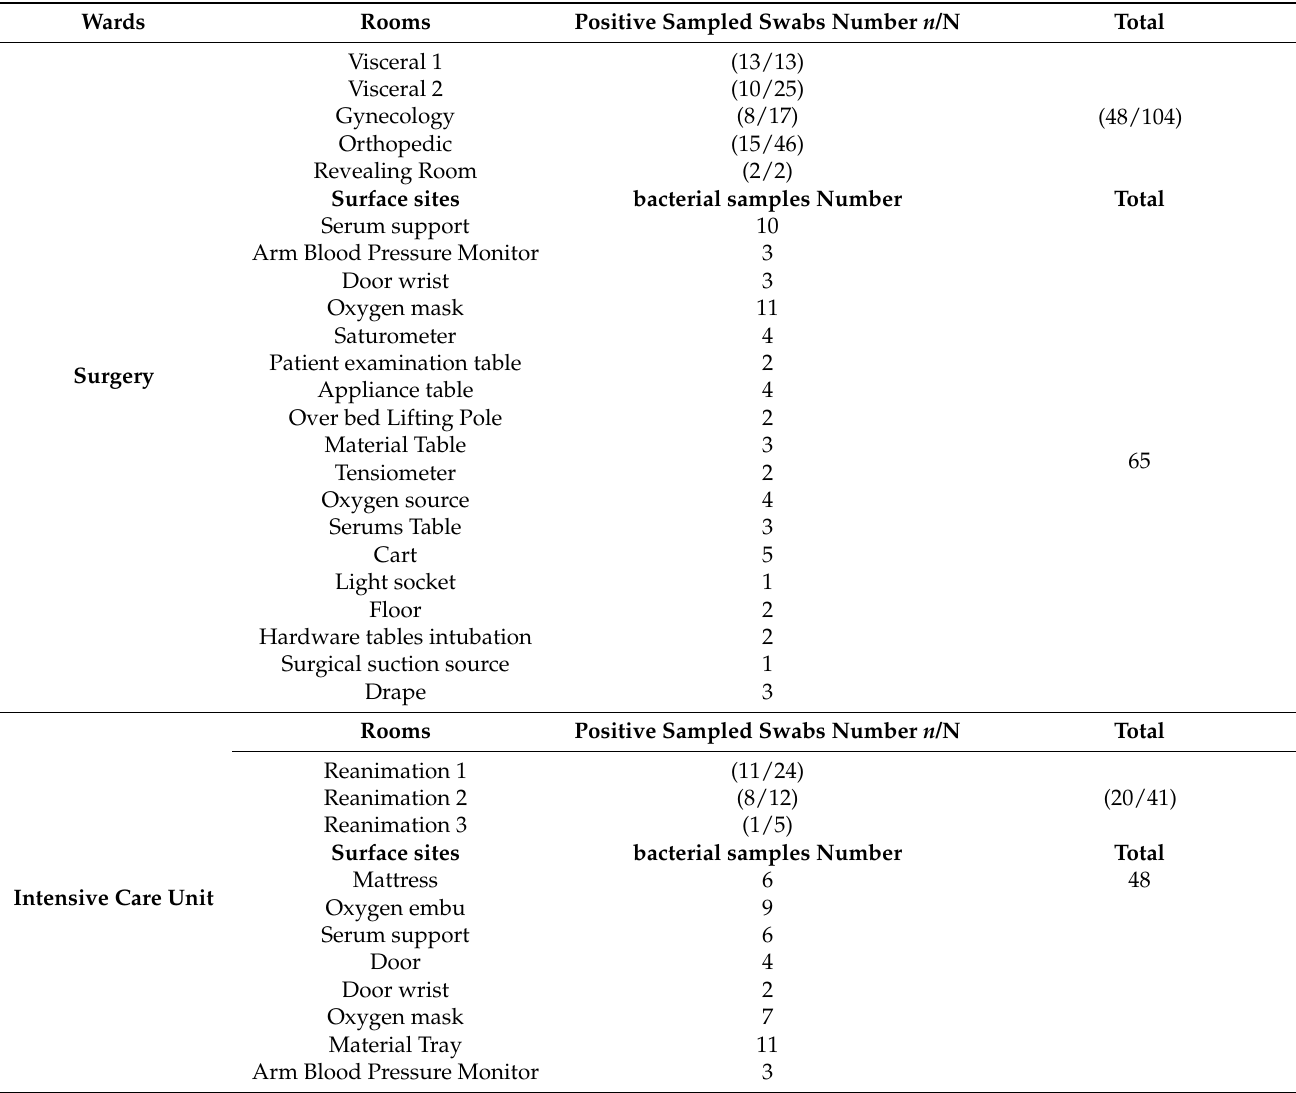
Table 1. Number of Positive Bacterial sampled swabs and bacterial samples according to different wards, rooms and surfaces in the